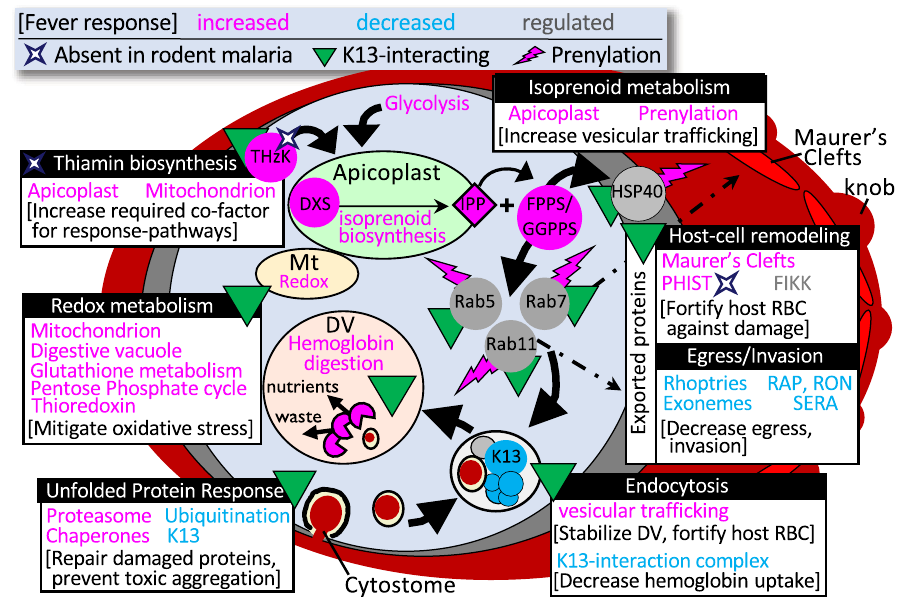
Fig. 7 Proposed model integrating key pathways underlying the parasite survival of host fever and artemisinin resistance. All pathways were identi fi ed via pooled phenotypic screening. The direction of regulation in response to HS is informed by comparative RNAseq data where available (pink = increased; blue = decreased). Pathways/proteins previously identi fi ed as interacting with K13 are indicated (green triangle). Prenylated proteins are indicated with a pink lightning bolt. Proteins without orthologs in rodent malaria parasites (whose hosts are non-febrile) are indicated with a white diamond. FV food vacuole. Modi fi ed from Oberstaller et al. 59 . Source data are provided as a Source Data fi